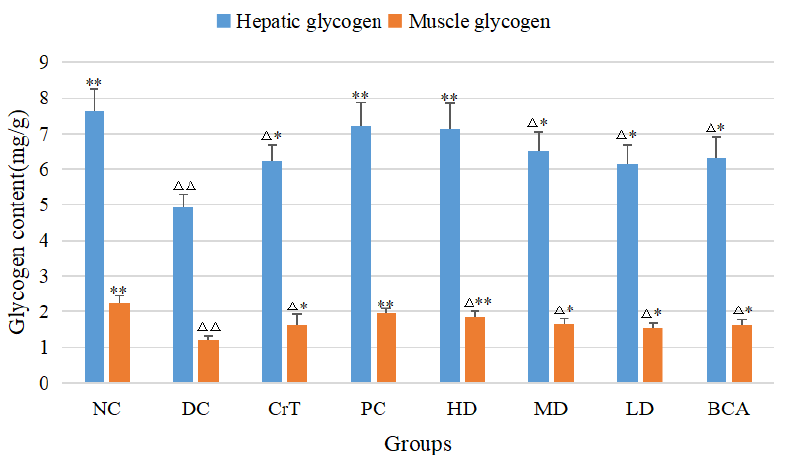
Figure 15. Effects of [CrBCA 3 ] on glycogen levels in db/db mice. Values are means ± SD ( n = 7). The differences between these groups and the NC group were statistically significant (denoted by “ (cid:52) ” or “ (cid:52)(cid:52) ” for p < 0.05 or p < 0.01, respectively); the differences between these groups and the DC group were statistically significant (denoted by “ * ” or “**” for p < 0.05 or p < 0.01,